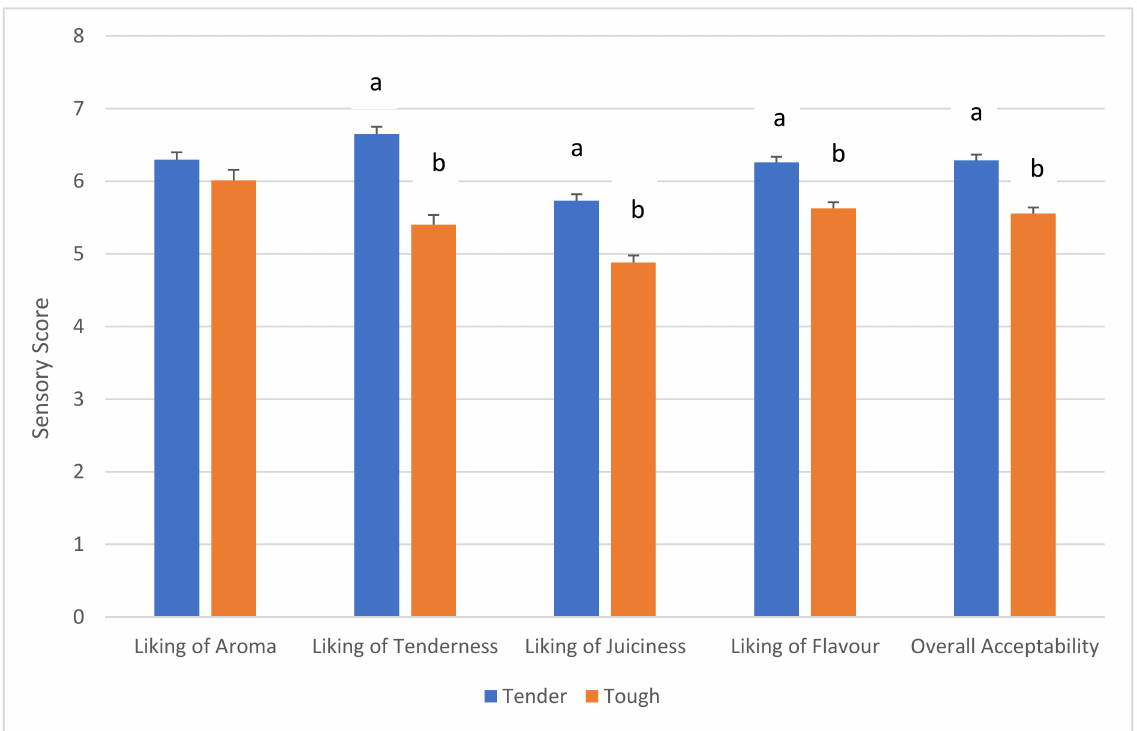
Figure 1. Consumer evaluation (hedonics) of beef from the Tough and Tender genotypes. Mean data with standard error of the mean (SEM). Lower case letters (a,b) denote significant differences ( p < 0.0001) between